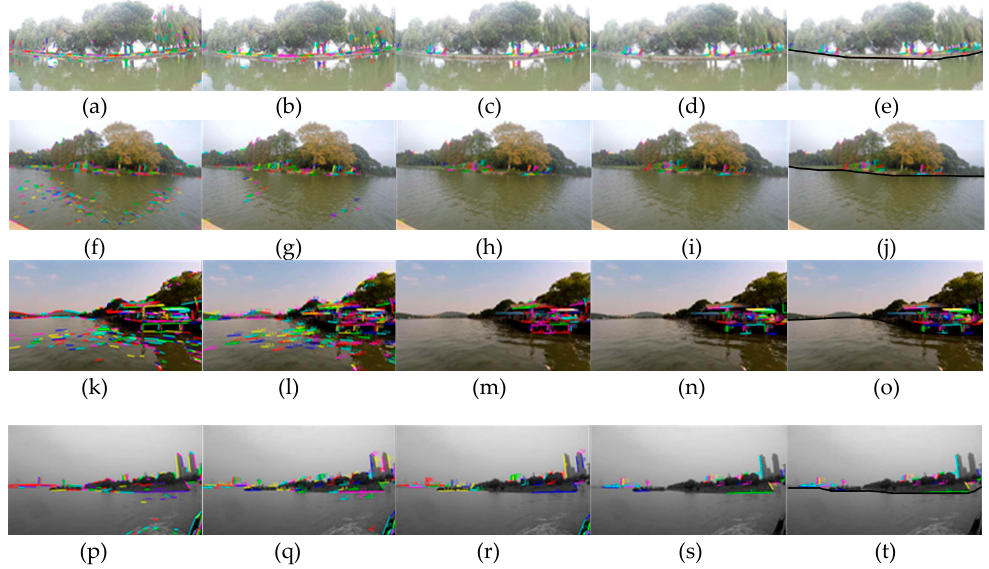
Figure 15. The second group of the WSL detection experiments in the case of non-straight line: ( a )–( e ) and ( f )–( j ) are experiments in sunny days, the five columns from left to right correspond to line segment extraction, line segment matching, line segment pool rough selection, line segment pool fine selection and WSL generation. ( k )–( o ) and ( p )–( t ) are experiments in cloudy days.